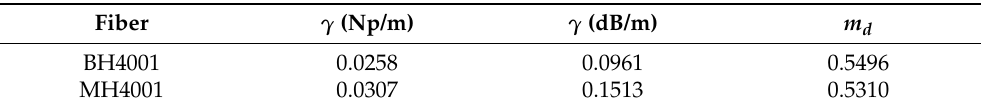
Table 3. Parameters of the overall attenuation and mode delay characteristic functions for the BH4001 and MH4001